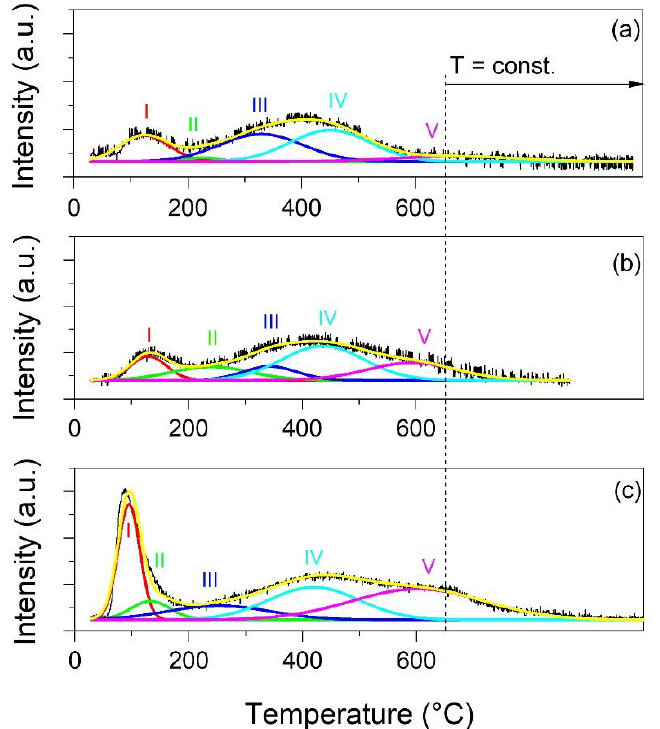
Figure 7. Temperature-programmed desorption of CO 2 (TPD-CO 2 ) over ( a ) 2K/Co4MnAl; ( b )